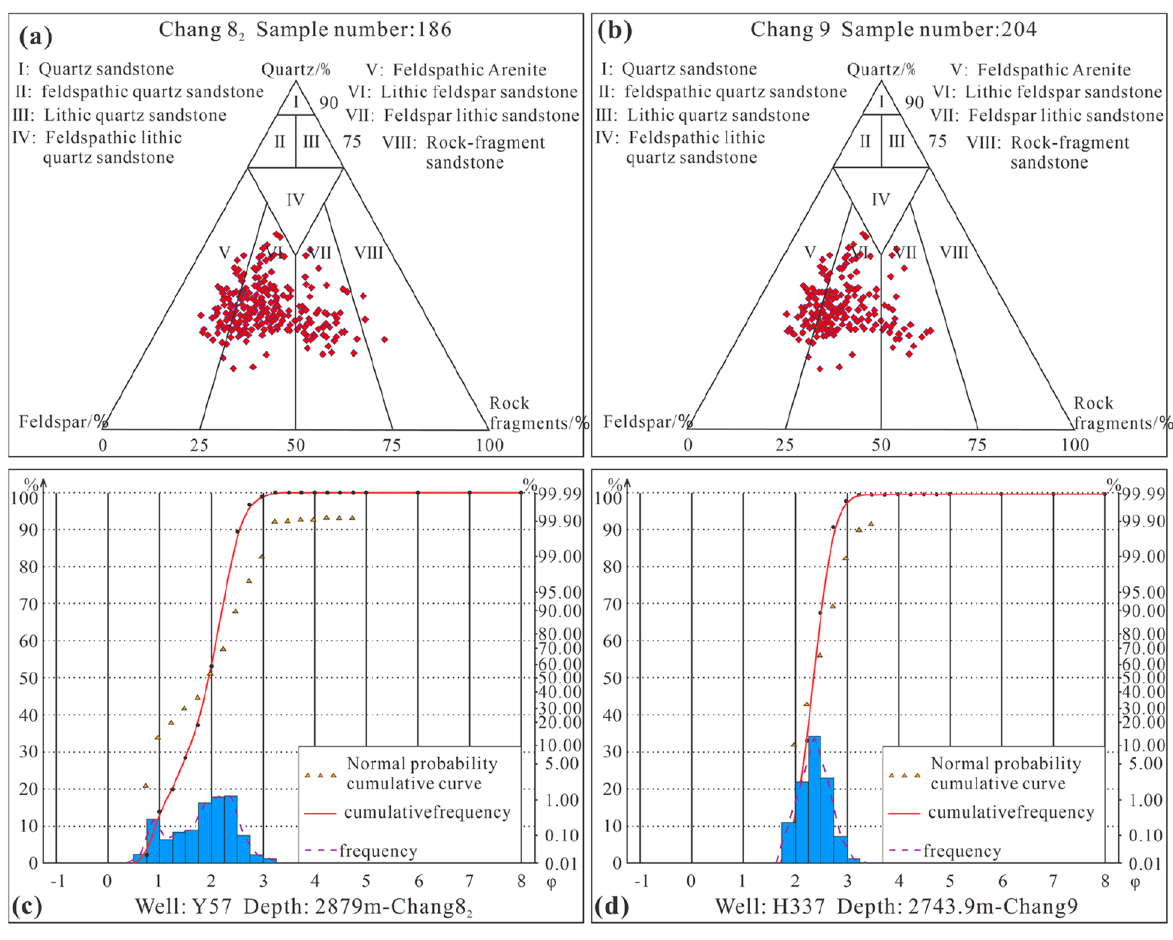
Figure 5. Rock composition and structural characteristics. ( a ) Ternary diagram of rock composition of sub-oil- bearing Chang 8 2 ; ( b ) Ternary diagram of rock composition of oil-bearing Chang 9; ( c ) Grain size distribution and cumulative distribution curve of sub-oil-bearing Chang 8 2 in Well Y57, 2879 m; ( d ) Grain size distribution and cumulative distribution curve of oil-bearing Chang 9 in Well H337, 2743.9